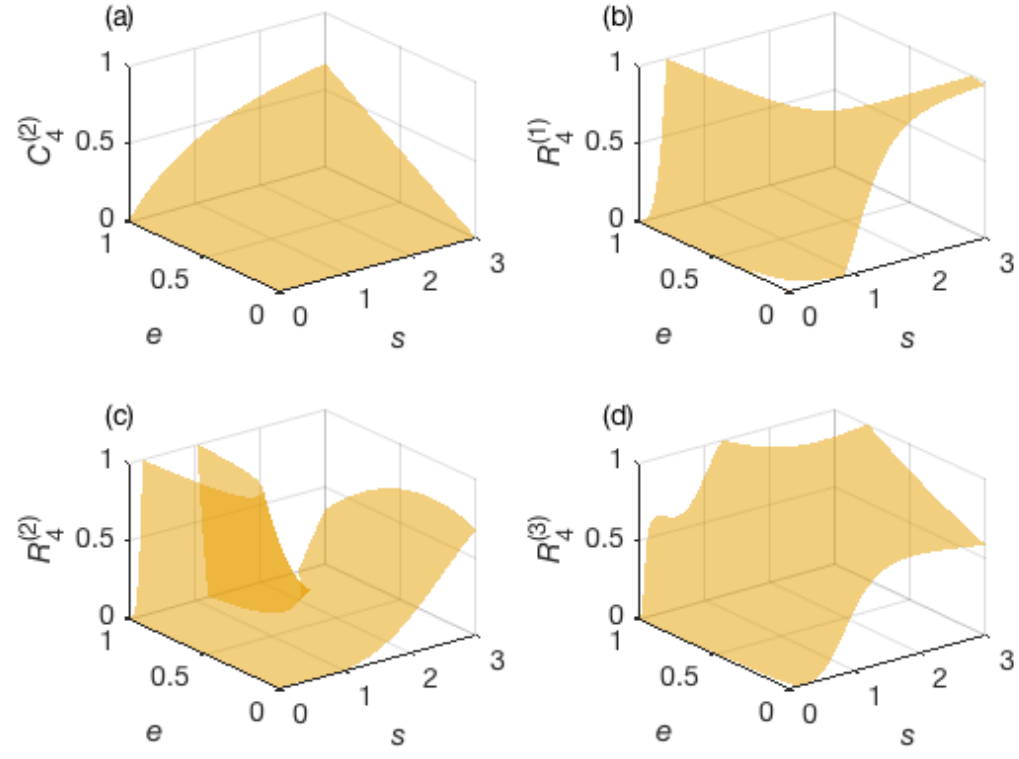
Figure 9. Computed inertial manifolds for ε 1 = 0.1, ε 2 = 0.01, β = 0.1, α = 1, κ = 0.01, γ = 1.5, n = 4 ( 2 ) and δ = 3. ( a ) C , a representative approximation of the inertial manifold C ( e , s ) . ( b ) R 4 ( 3 ) ( d ) R 4